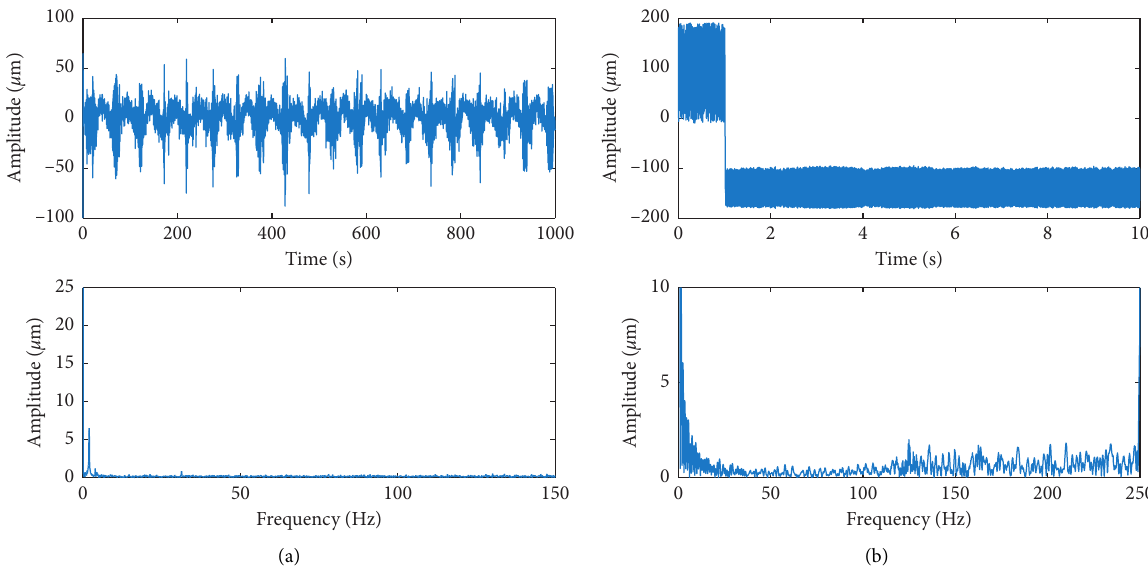
Figure 5: Actual signal processed by GA-SR. (a) Y -direction swing signal at the flange. (b) Vibration signal at the draft